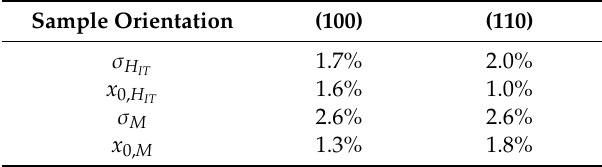
Table 3. Fitted values for x 0 in comparison to σ of the corresponding data sets from the measurement series of the azimuthal indenter orientation influence on H IT and M